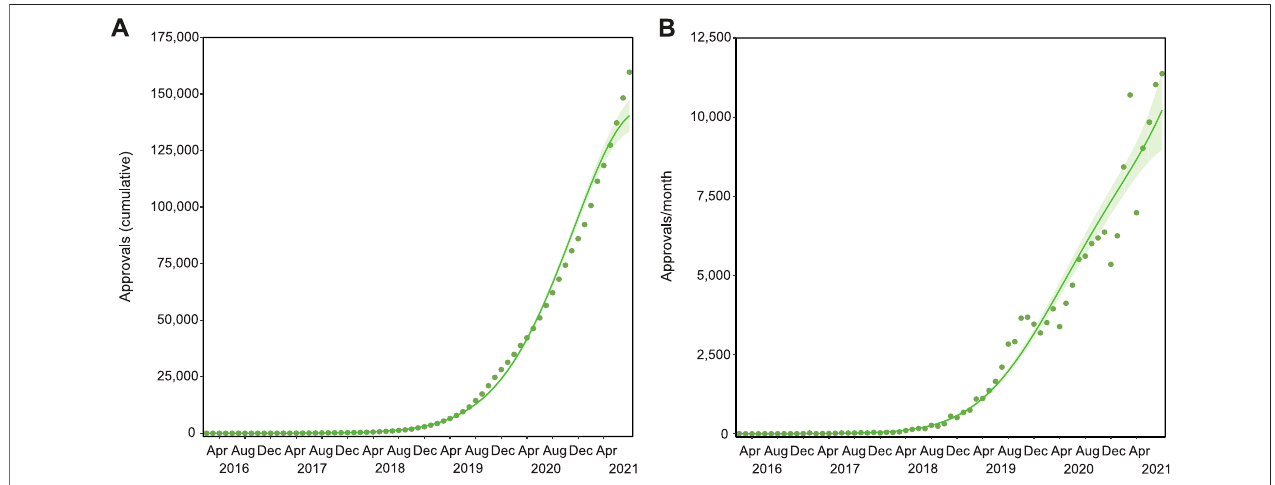
FIGURE 1 | SAS-B approvals over time. There have been 159,665 cumulative SAS-B approvals since 2016, with growth that followed a Negative binomial, 3rd degree polynomial curve (R 2 = 0.998, Δ m = 44.398; (A) . Applications per month increase by around 12,000 a month, following a Negative binomial, 4th degree polynomial curve (R 2 = 0.984, Δ m = 22.590; (B) . Solid lines represent the best fi t with shaded standard error of the mean